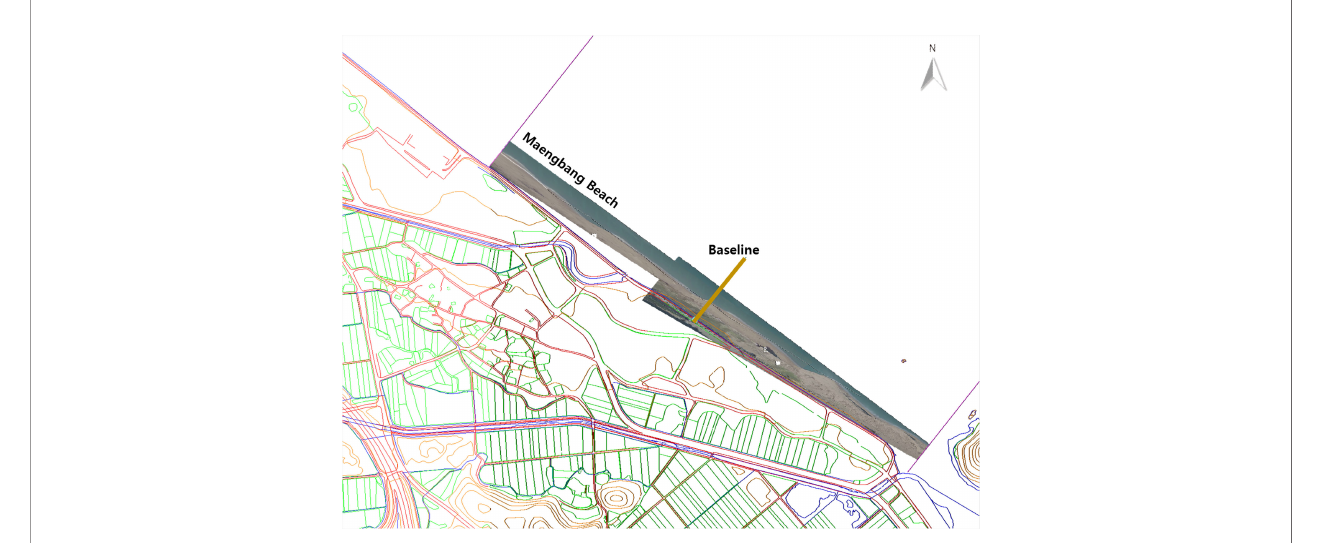
FIGURE 8 | Geometry correction of CCTV images at Maengbang Beach.